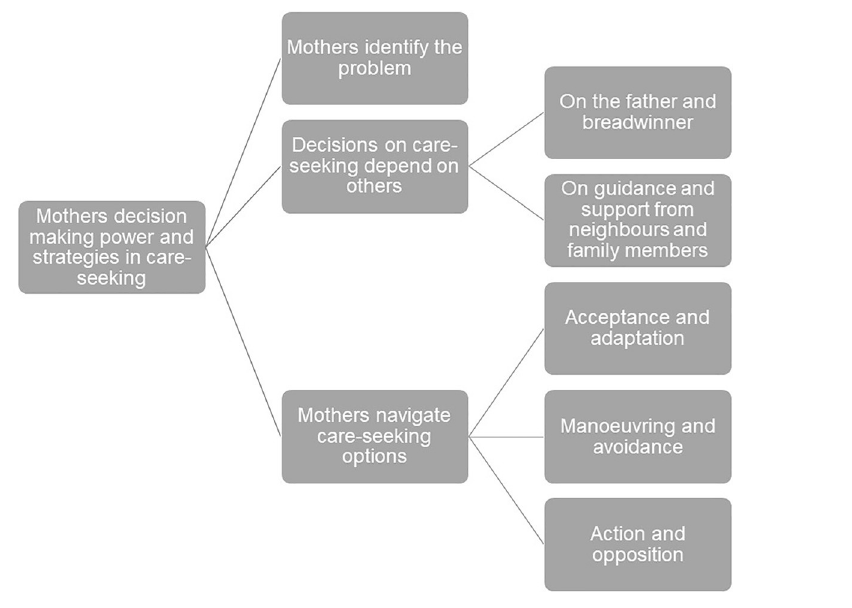
Fig 1. Themes and